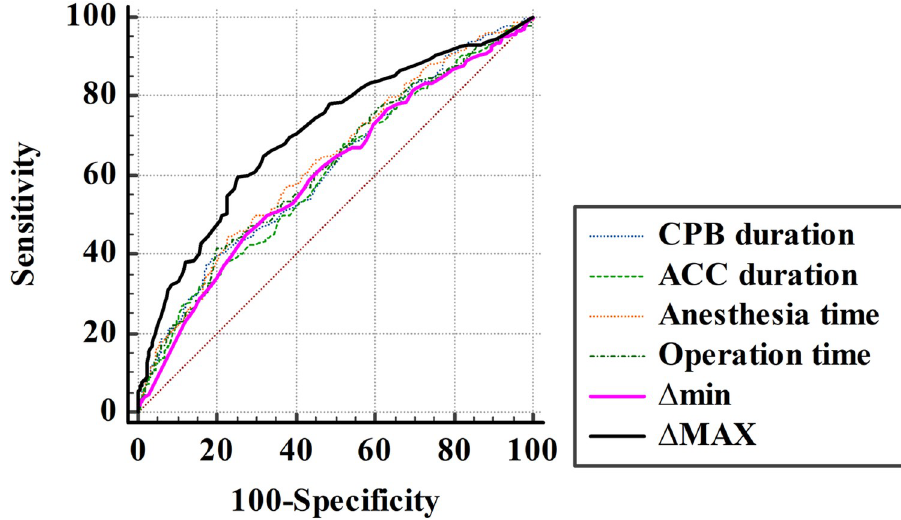
Fig 2. Receiver operating characteristics (ROC) curves. The AUROC for intraoperative data CPB duration, ACC duration, anesthesia time, operation time, Δ min and Δ MAX were 0.618, 0.603, 0.633, 0.619, 0.603 and 0.706, respectively. Δ min is Δ (baseline–maximum rSO 2 ), and Δ MAX is Δ (baseline–minimum rSO 2